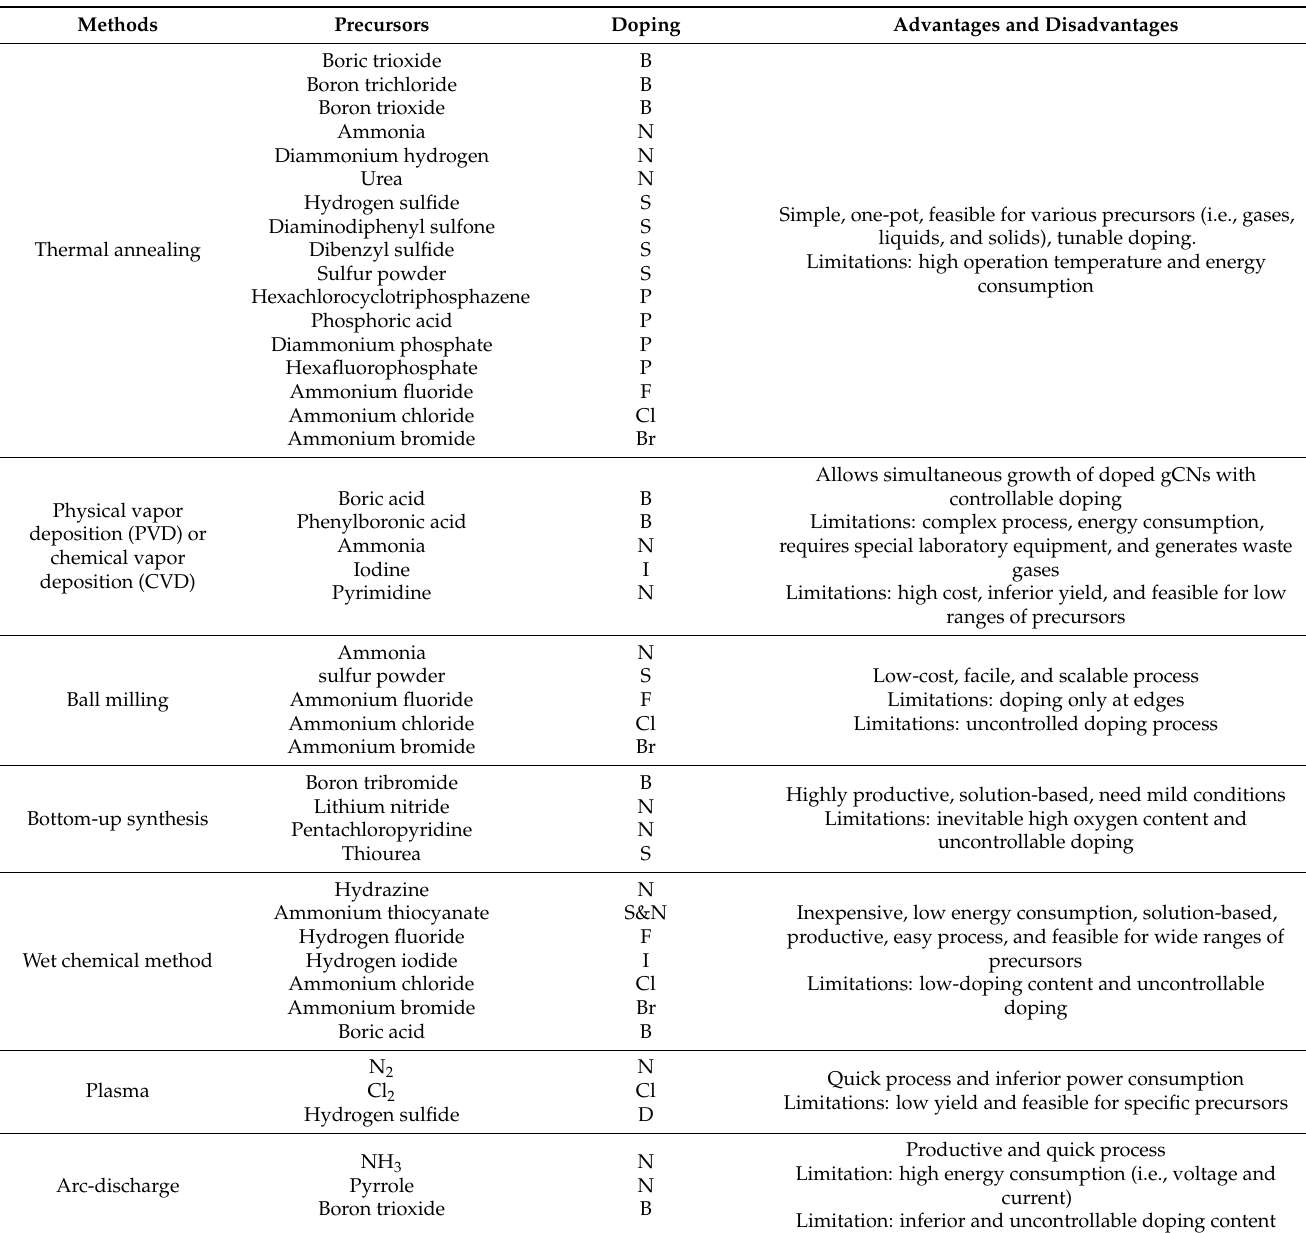
Table 5. Comparison between the preparation methods of doped gCN nanostructures based on data from Refs.